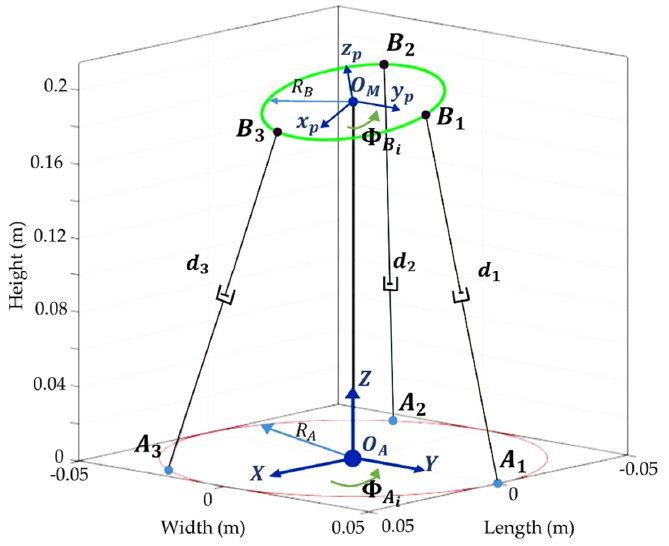
Figure 2. Schematic of the 3 DOF parallel mechanism employed in the propulsion system.